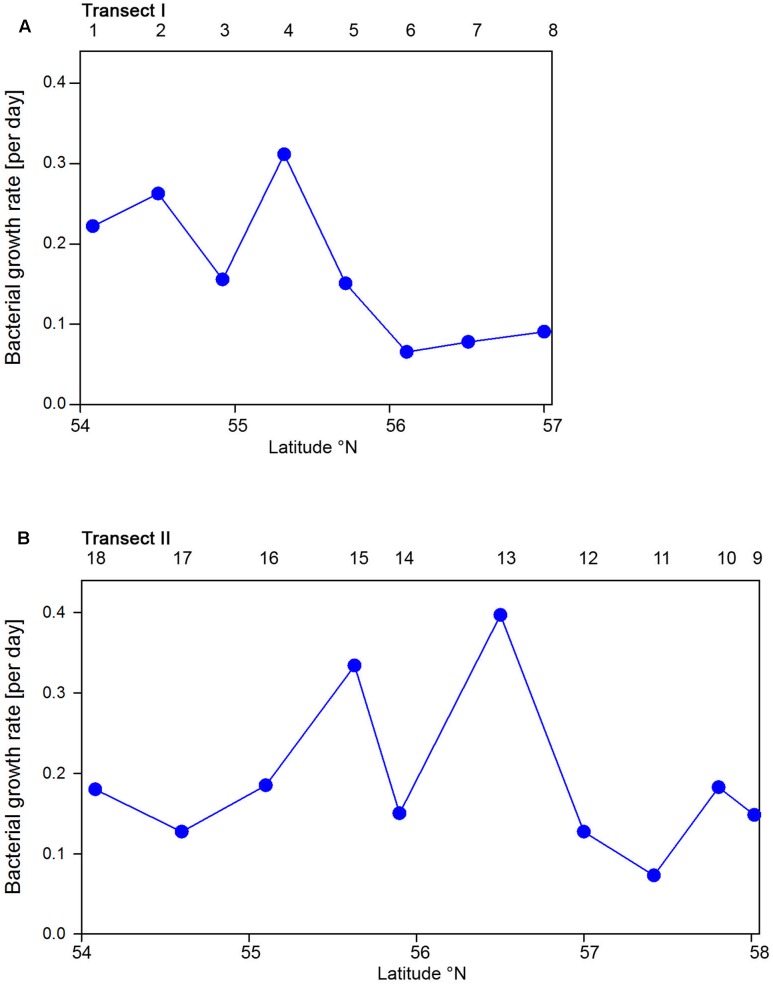
Bacterioplankton bulk growth rates of Transects I (A) and II (B) during early summer in the North Sea between 54° and 58°N. The numbers above the panels indicate station numbers.